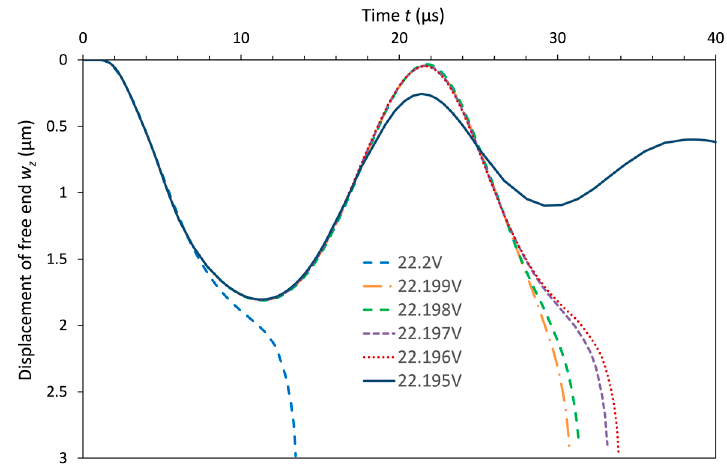
Figure 12. Additional temporal response curves of the same Al MEMS cantilever tip for different applied voltages. applied